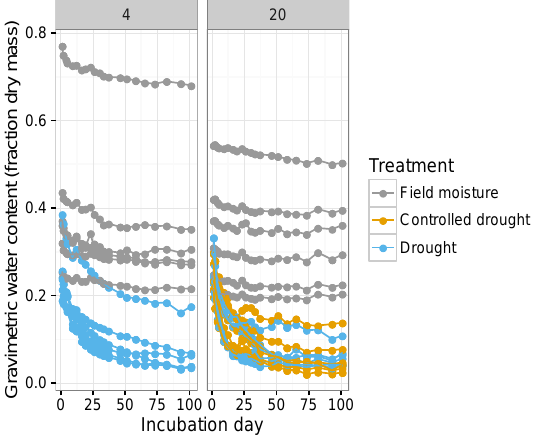
Figure 1. Core water content across the course of the incubation experiment by temperature (left panel 4 ◦ C, right panel 20 ◦ C) and treatment.